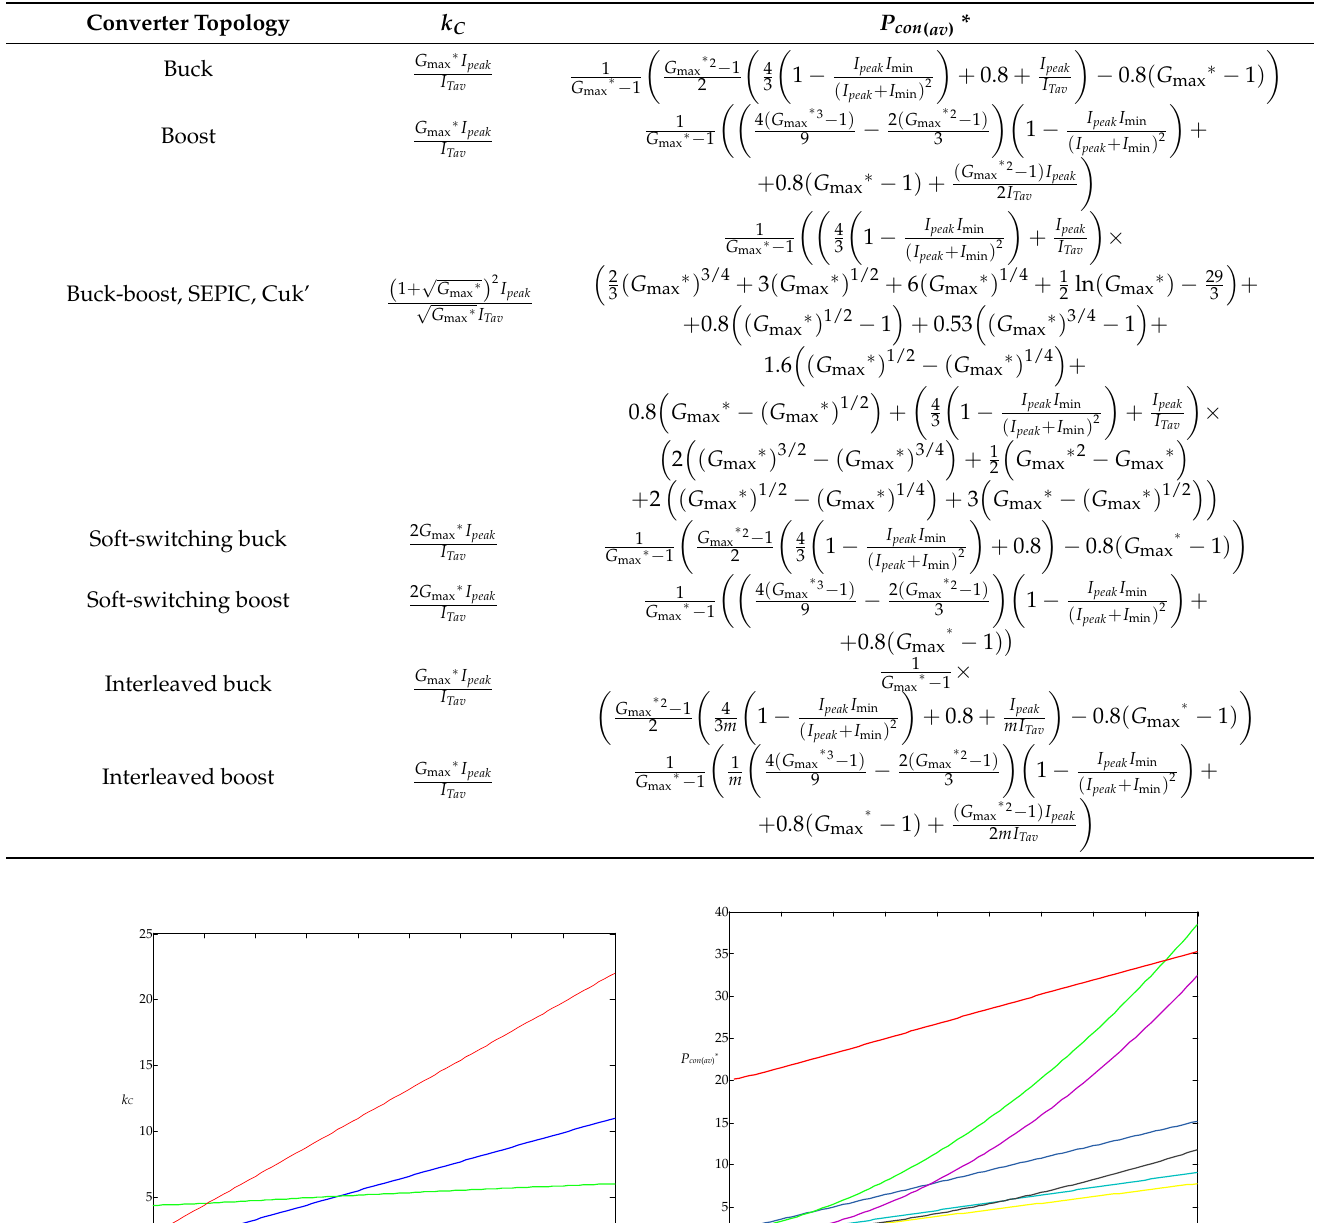
Table 10. Comparative analysis of the DC–DC converter’s effectiveness in space of the variable G *.